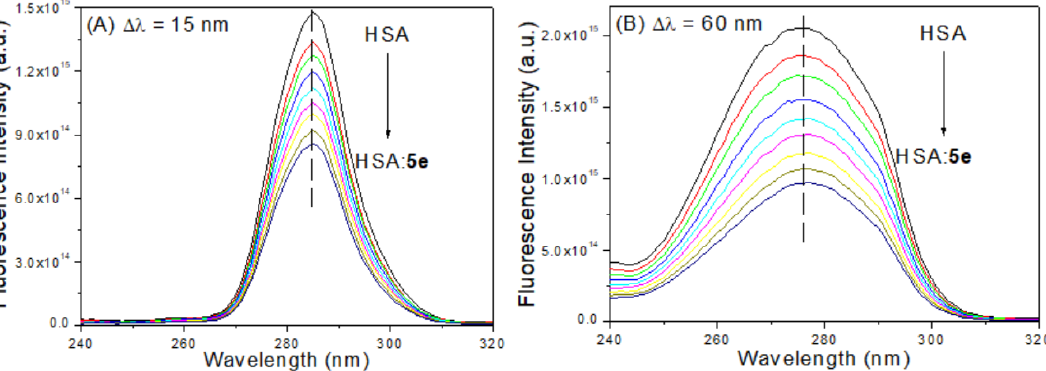
Figure 6. Synchronous fluorescence (SF) spectra for HSA without and in the presence of 5e at ( A ) Δλ = 15 nm and ( B ) Δλ = 60 nm. [HSA] = 1.00 × 10 −5 M and [ 5e ] = 0.35; 0.70; 1.05; 1.40; 1.74; 2.09; 2.44; and 2.78 × 10 −5 M.